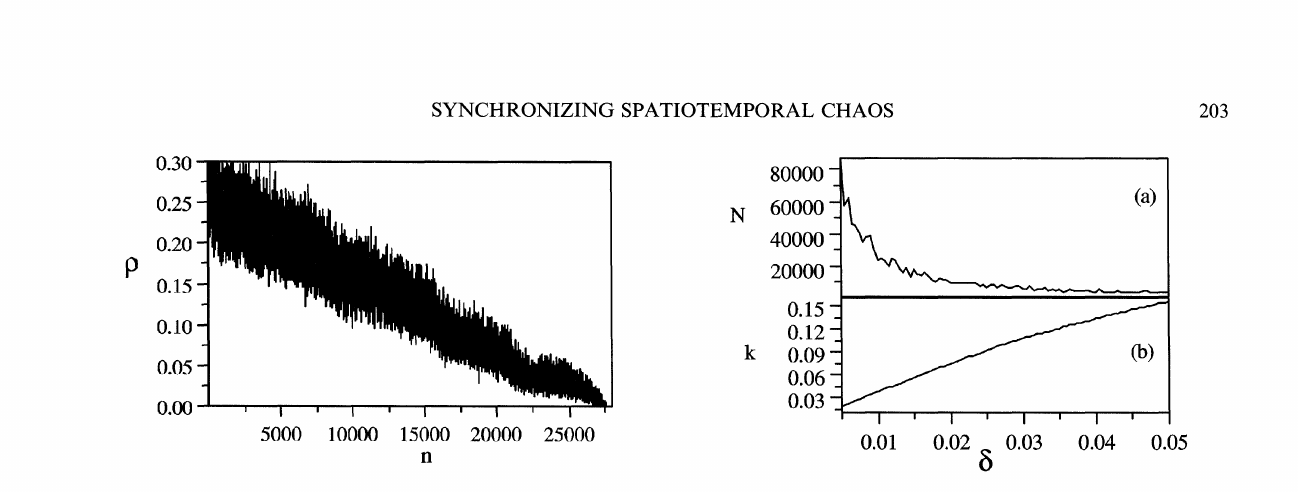
A plot of time versus the average absolute dif- FIGURE 2 (a,b) Plots with the parameter versus (a) the ference p with e =0.25, p =0.8 and M 100. number of iterations N required for synchronization, and (b) the percentage of modified fields k. The two subsystems are one-way coupled map lattices with M 100 and e- 0.25. The are in synchronization and the average absolute location of the finite flat region is p--0.8. difference is smaller than 10-18, which cannot be distinguished in our computer.